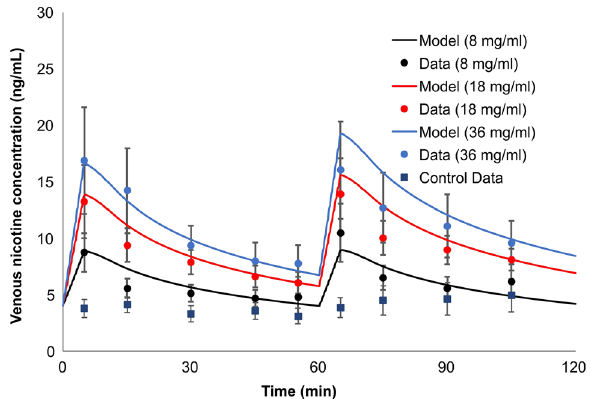
Figure 16. Simulation of the nicotine venous plasma time-course in 16 ENDS-naïve cigarette smokers after two uses (1 h interval) of an ENDS device reported 32 . The nicotine content of the e-liquids was reported as 8, 18, and 36 mg/mL. Subjects were asked to take 10 puffs with 30 s puff intervals. Error bars represent one standard